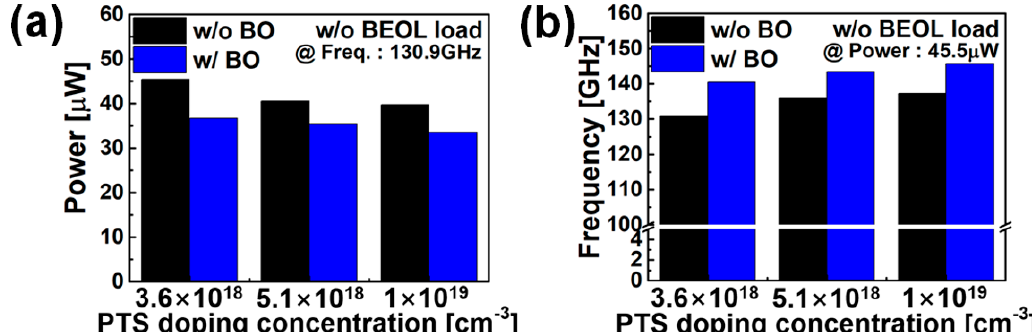
Figure 8. PPA summaries of nine stages RO in condition of ( a ) iso-speed ( b ) iso-power.